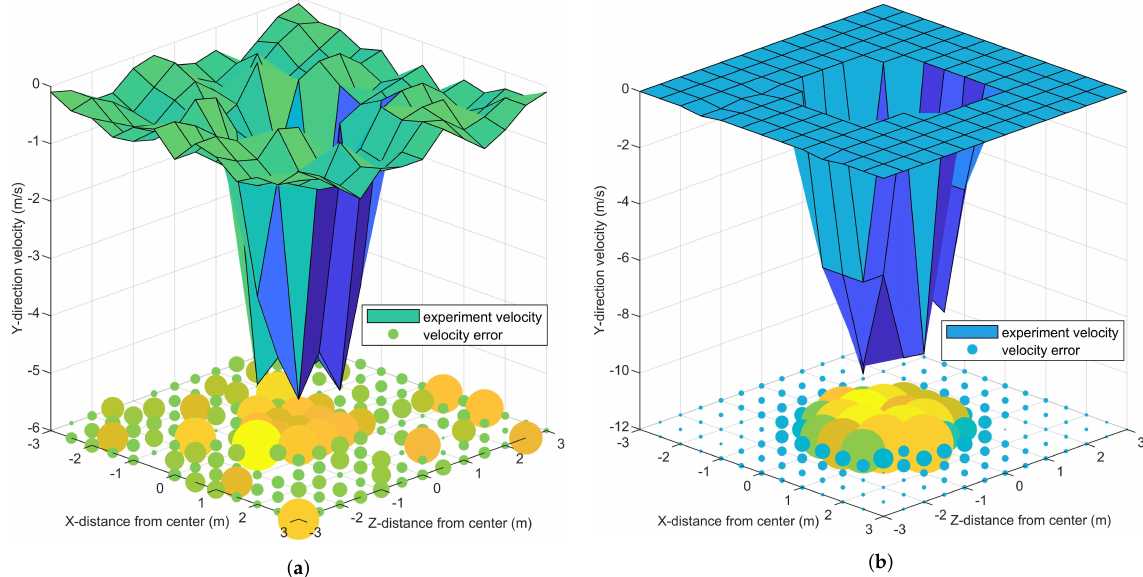
Figure 5. Wind field distribution in the simulation and experiment. ( a , b ) show the distributions of wind velocity in Y − direction at the planes of Y = {0.5, 1.5 m} and the absolute value of wind velocity error between the simulation and